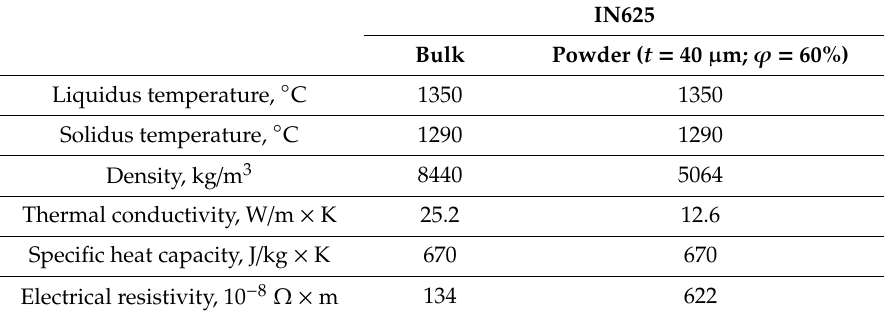
Table 4. Physical properties of IN625 bulk and powdered alloy used for melt pool modeling [27,38].